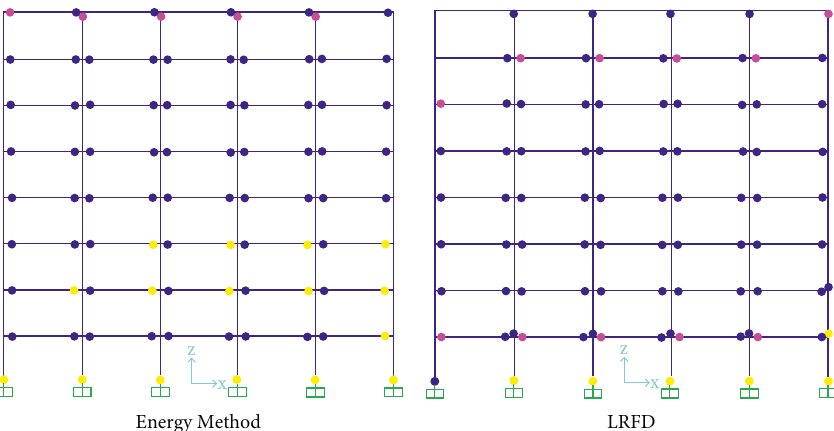
Figure 12: Plastic hinge created on an 8-story frame designed by the energy and LRFD methods.